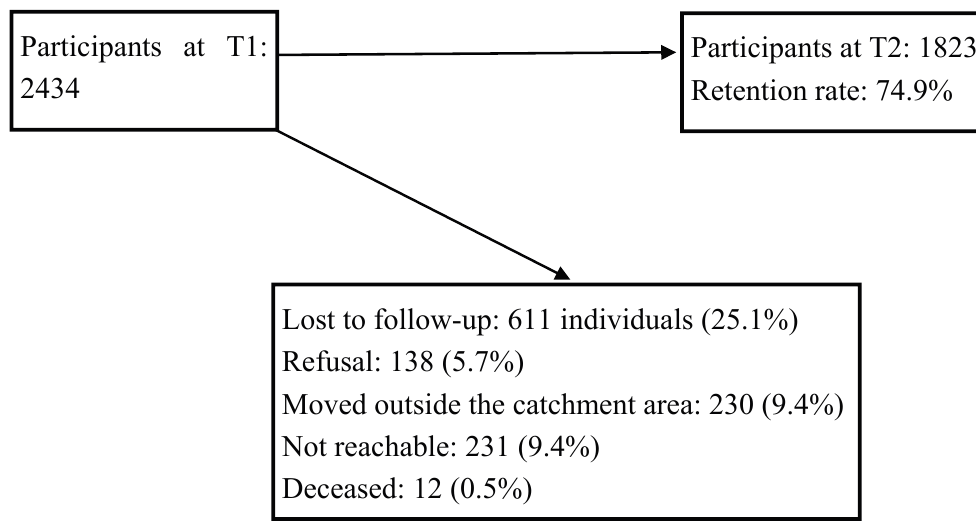
Figure 1. Flowchart of the sample from baseline (T1) to second survey